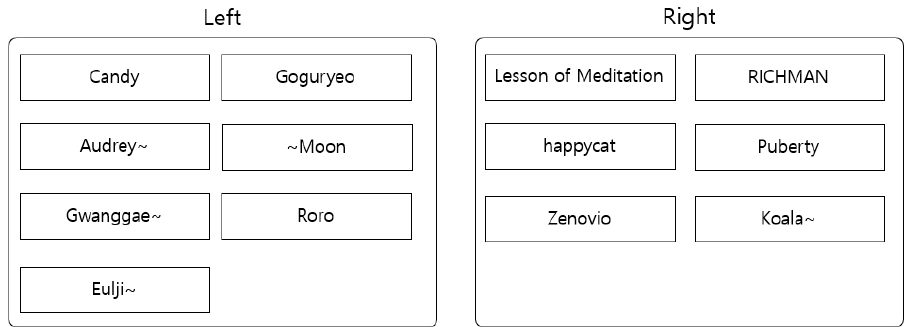
Figure 9. Top users’ political stance .